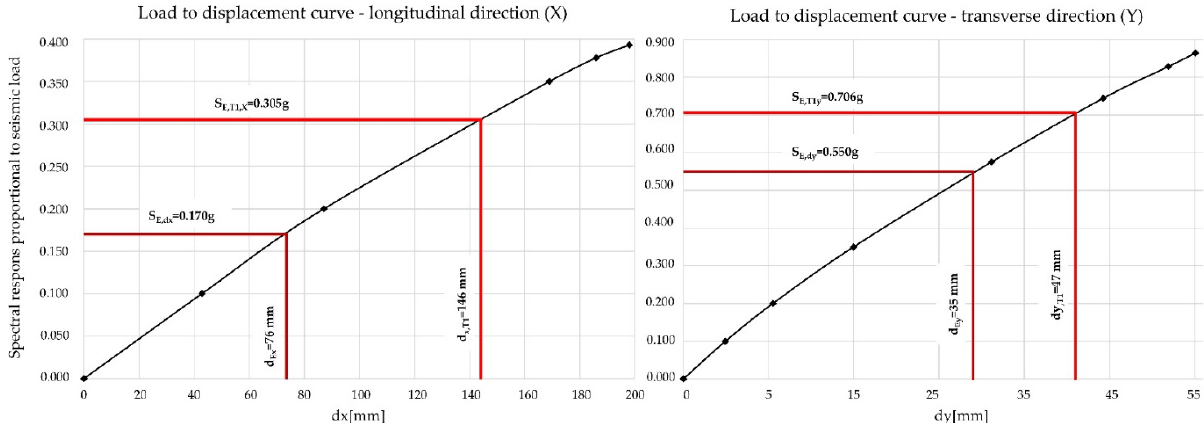
Figure 10. Load–displacement curves for the First Case Study bridge, longitudinal ( left ) and trans- verse ( right ) direction.